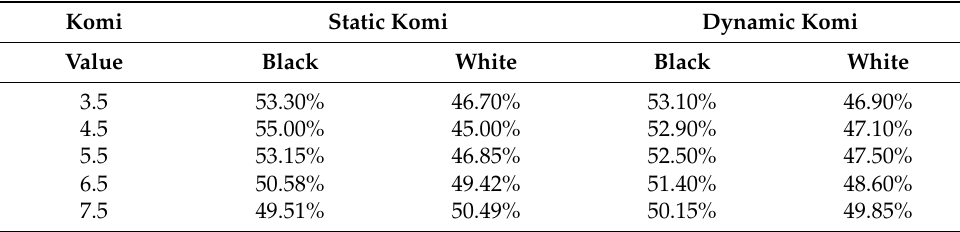
Table 2. Winning rate analysis based on static komi versus dynamic komi in the game of Go. Komi Static